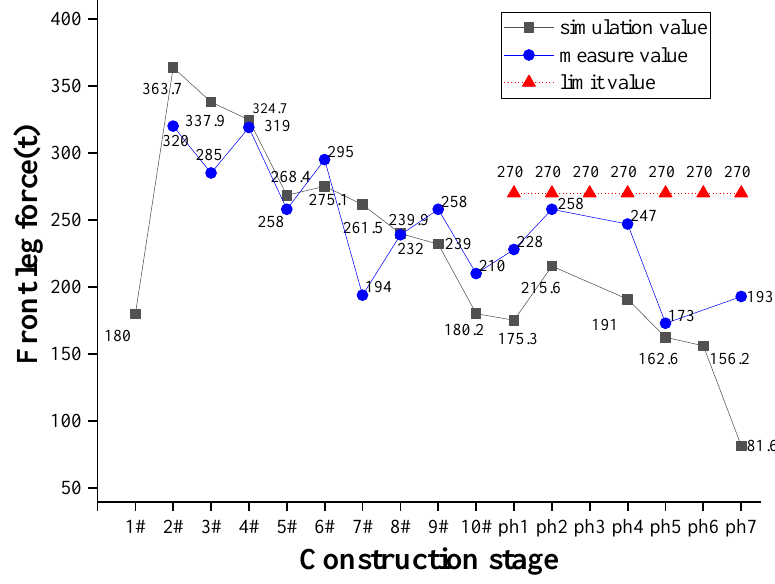
Figure 17. Front leg force.